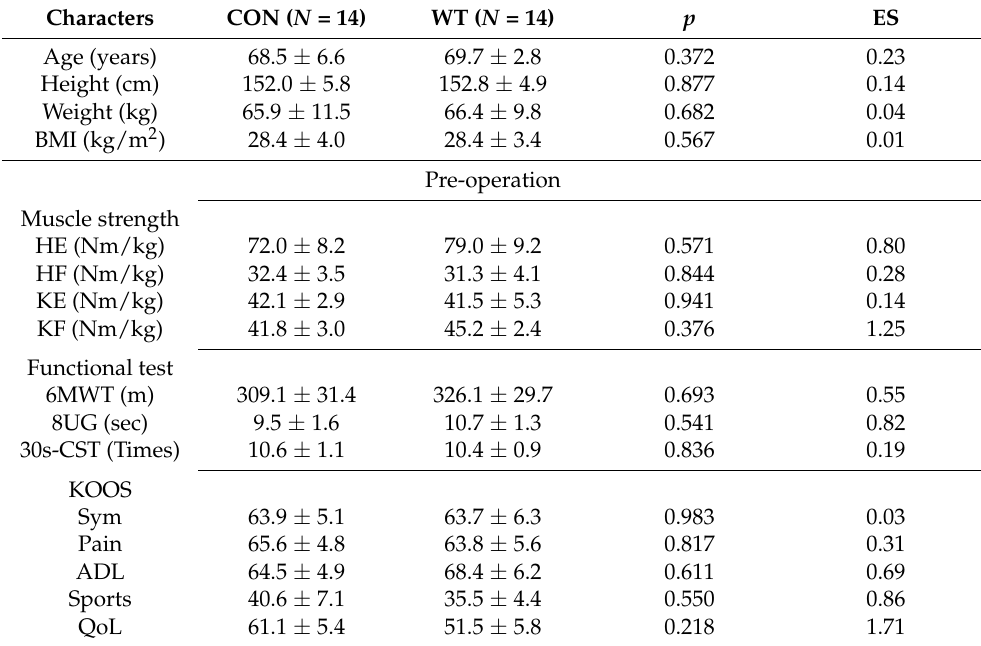
Table 1. The demographic characters of patients at the pre-operative